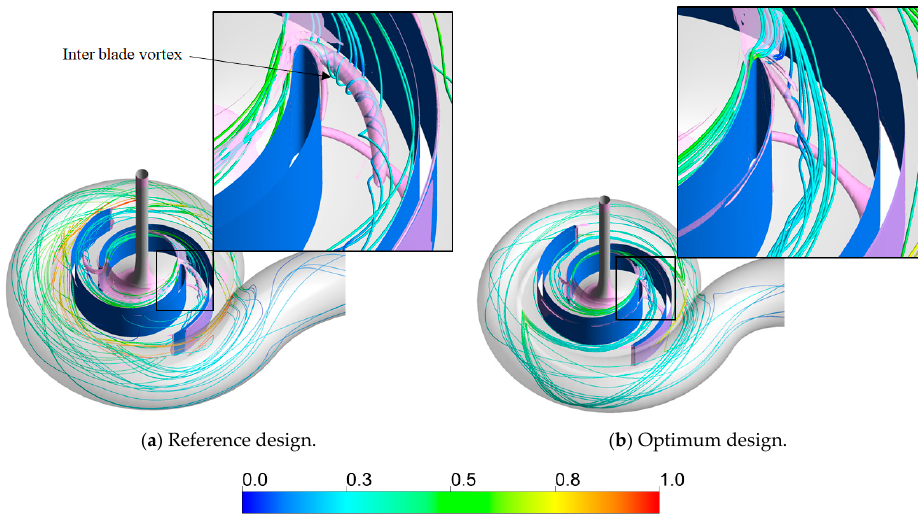
Figure 20. Three-dimensional (3D) streamlines with vortices distribution on the iso-surface of the velocity invariant ( > 5 × 10 5 s − 2 ).